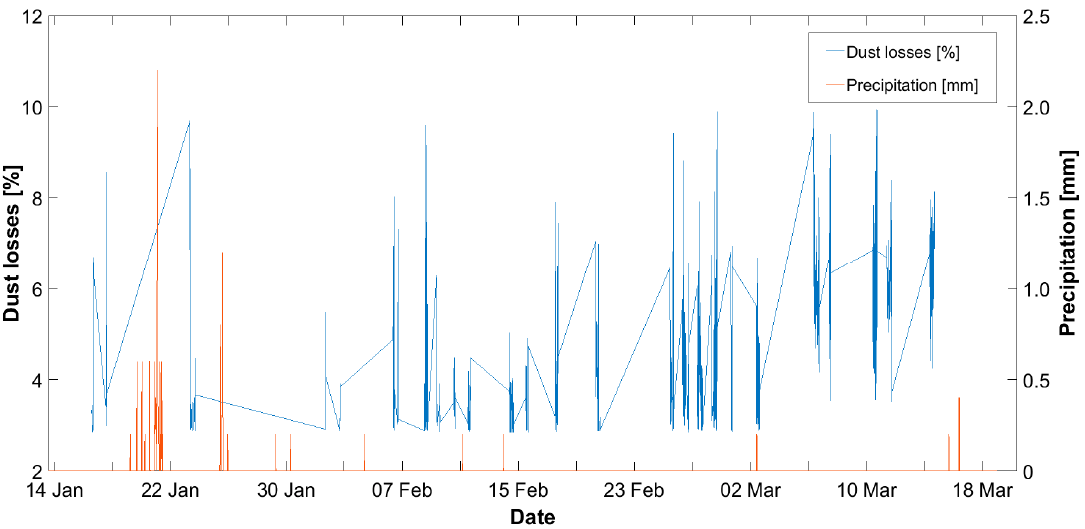
Figure 7. Effect of rainfall on the variation in production loss during several months.